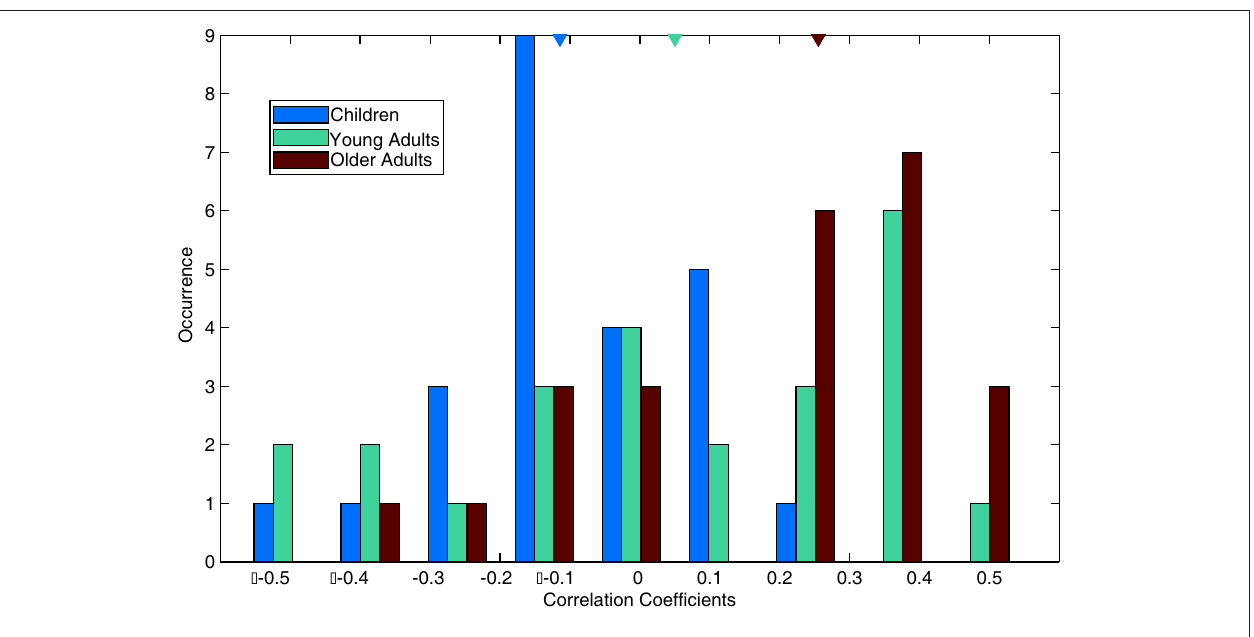
Figure 8 | Age differences in correlations between explorativeness and feature the distribution of 24 correlation coefficients for each age group. The triangles above AuCs. For each feature and category combination (only fractals and manmades ), show age group medians. Note the predominantly negative correlations of children, subject-specific AUCs (AUC ) were correlated with subjects’ explorativeness. Since the positive correlations of older adults and the presence of roughly equal amounts of S there were 12 features and 2 categories of interest, the frequency histogram displays positive and negative correlations for young